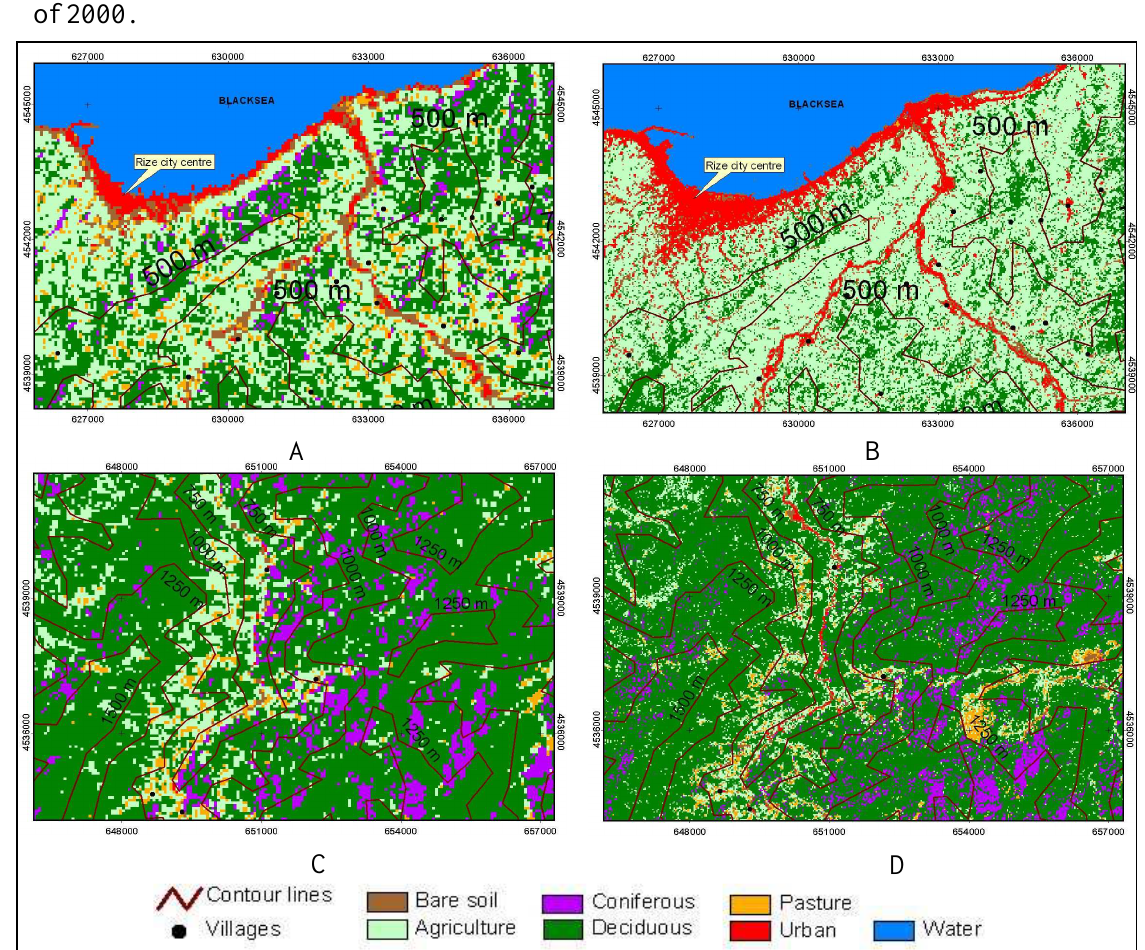
Figure 4. Example of Land use\land cover map with elevation, A) Coastal area of 1976, B) Coastal area of 2000, C) high mountainous area of 1976, D) high mountainous area of